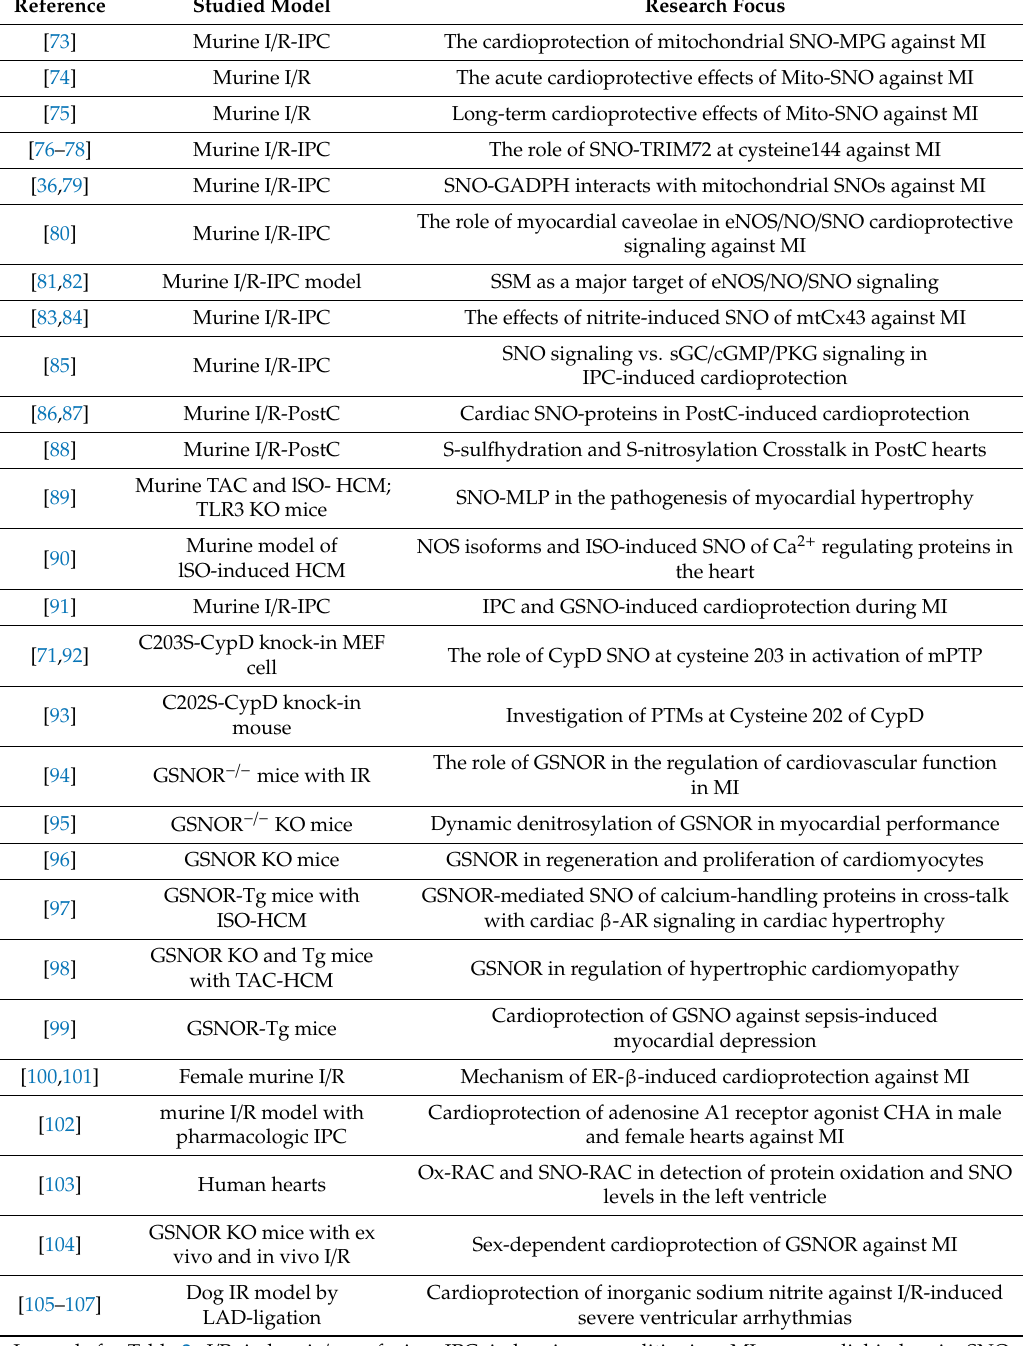
Legends for Table 2: I / R: ischemia / reperfusion; IPC: ischemic preconditioning; MI: myocardial ischemia; SNO: S-nitrosylation; SNO-MPG: S-nitroso-2-mercaptopropionyl glycine; Mito-SNO: mitochondria-targeted S-nitrosothiol; SNO-TRIM72: